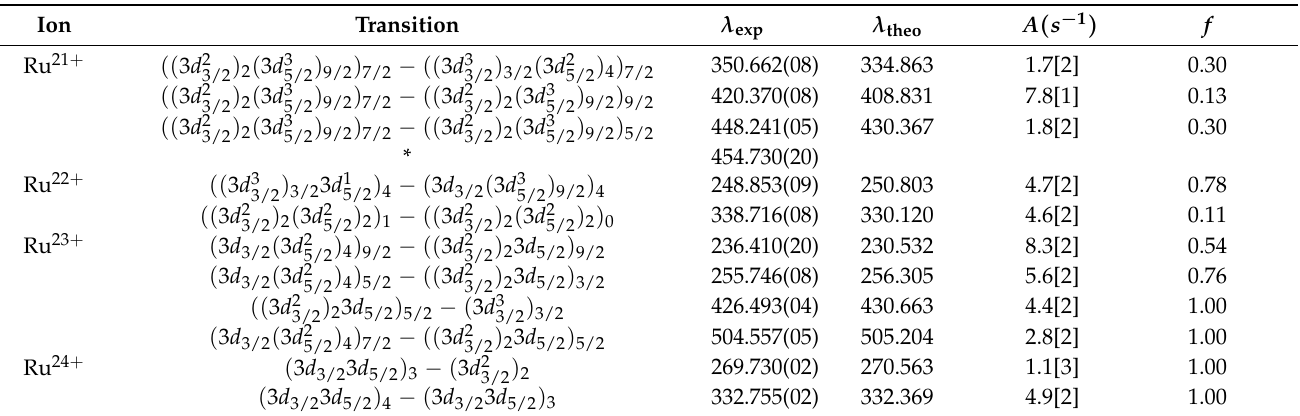
Figure 2. Observed spectra of Ru 21 + –Ru 24 + ions. ( a ) Lines of Ru 21 + , Ru 22 + at 1000 and 1100 eV, ( b ) lines of Ru 23 + , Ru 24 + at 1180 and 1400 eV. The lines labeled with arrows represent the transitions with highest intensity from different ions. Table 1. Observed forbidden lines of Ru 21 + –Ru 24 + ions. Wavelengths (nm, in vacuum) of experimen- tal and calculated results are listed in the column λ exp and λ theo , respectively. The corresponding transitions, transitions rates A , and branch ratios f are also given. The numbers in parentheses denote the uncertainties (one standard deviation), and notation a[b] for transition rates is a × 10 b . The lable ‘*’ indicates unidentified